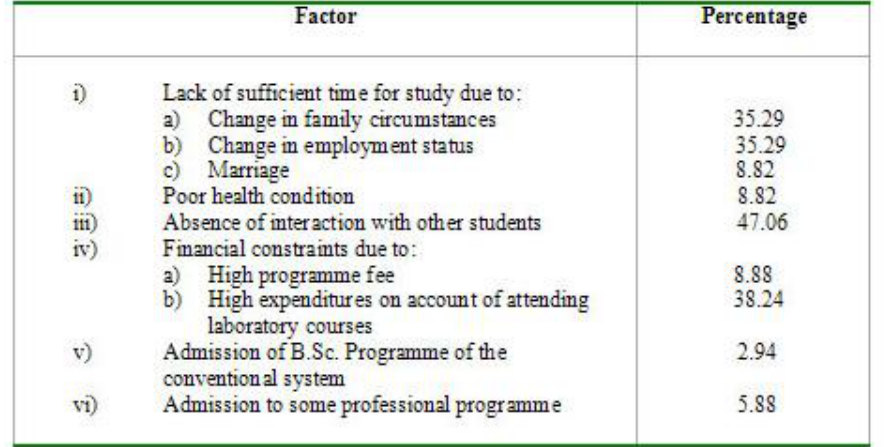
Table 2. Personal Reason as response for withdrawal (expressed as a percentage of total number of